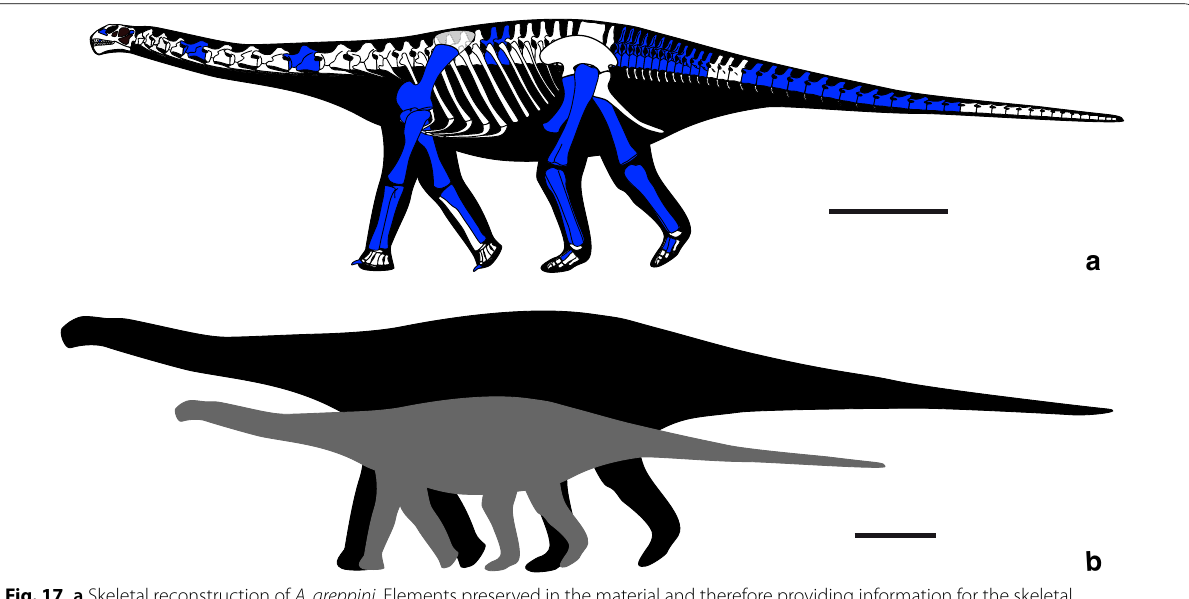
Fig. 17 a Skeletal reconstruction of A. greppini . Elements preserved in the material and therefore providing information for the skeletal reconstruction are marked in blue. Because much information is missing from the incomplete skeletal material, the dorsal vertebrae, the proportions and morphology of the cervical vertebrae and the skull were modified from Camarasaurus . b Scaled silhouette drawings of Cetiosauriscus stewarti (in black) and A. greppini (in grey) demonstrating the significant size difference between the two taxa. Scale bar is 1